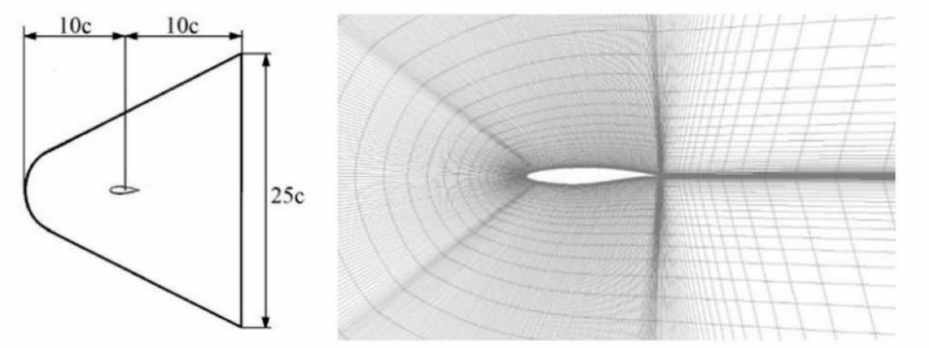
Figure 9. Domain size and numerical